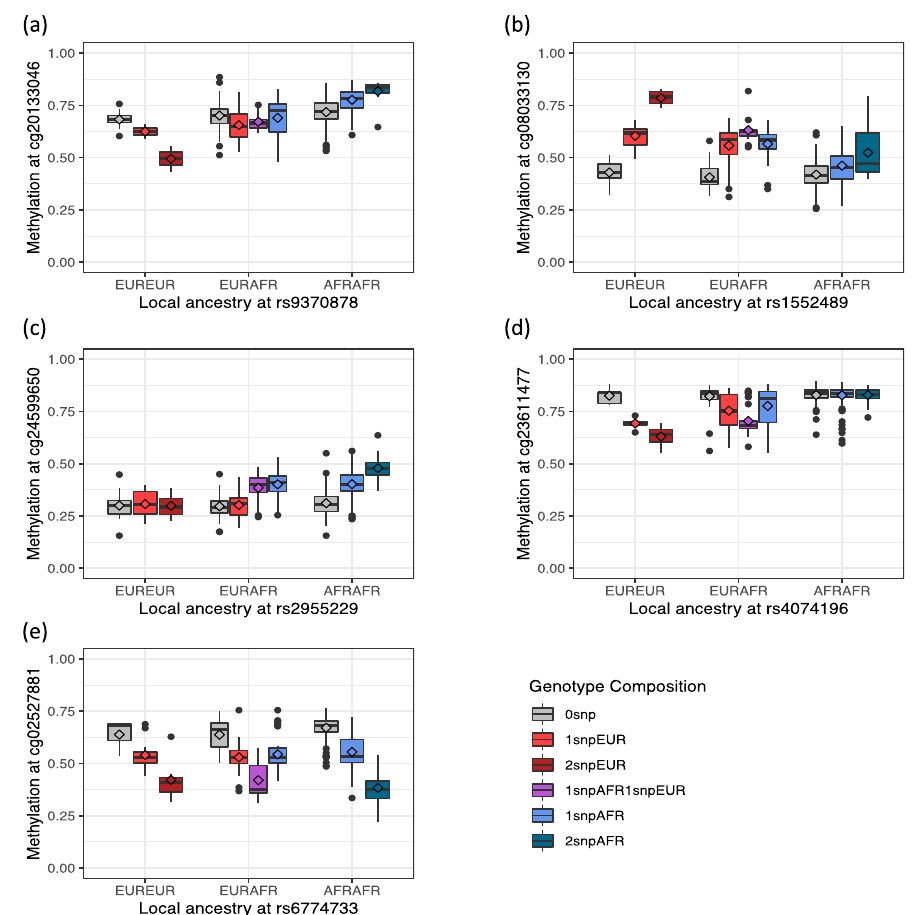
Fig. 5 An illustration of four representative patterns of genetic effects by ancestry for the meQTLs identi fi ed by the ancestral model. In each panel, the set of boxplots show the distribution of methylation (beta-value) by genotype composition. The lozenge indicates mean of methylation beta-value. a The genetic effects on the methylations are opposite for the African and European ancestry. b The genetic effects from the two ancestries contribute to the methylation in the same direction but with different effect sizes. c The African alleles are associated with differential methylations while the European alleles are not. d The European alleles are associated with differential methylations while the African alleles are not. e The genetic effects are comparable between ancestries. The box denotes interquartile range (IQR, 25th to 75th percentile) where the central line in the box denotes the median value (50th percentile) and the lozenge denotes the mean value. The upper and lower whisker denotes the largest value within 1.5 times IQR above the 75th percentile and the smallest value within 1.5 times IQR below the 25th percentile, respectively. Values outside of the whisker range are denoted as dots. The source data are provided in Supplementary Data 9 –